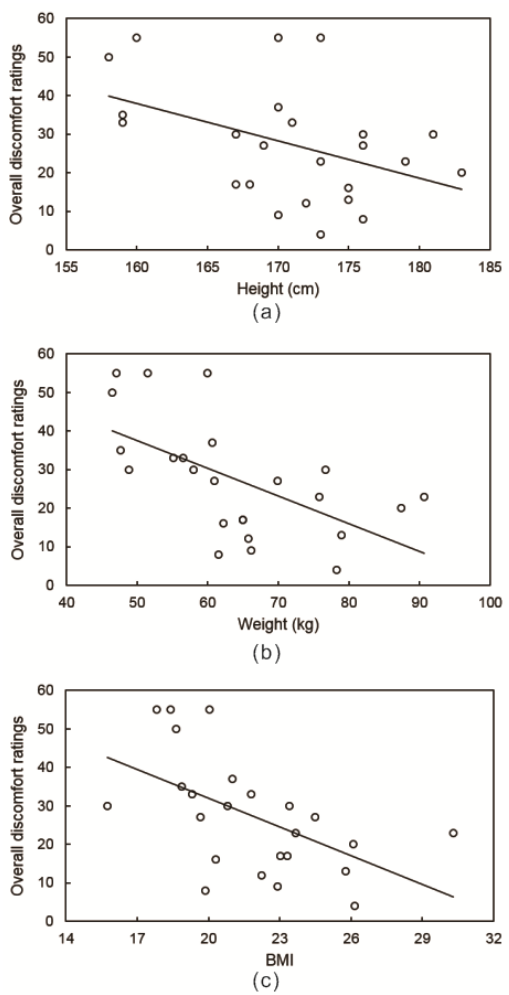
Figure 6. Scatter plot of overall comfort versus physiological parameters under the ”slow” speed condition of the ”rising” movement. ( a ) Height; ( b ) Weight; ( c ) BMI. condition of the “rising” movement. ( a ) Height; ( b ) Weight; ( c )